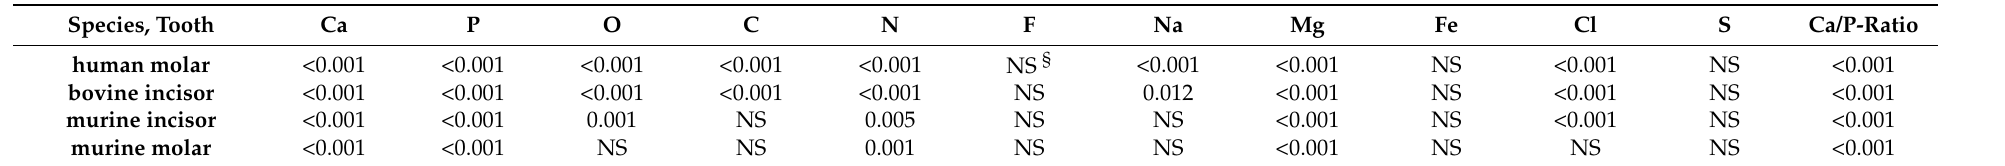
Table 2. p -values from pairwise tests between enamel and dentin for the summarized areas in every group of teeth for all elements and the Ca/P-Ratio (results depicted in Figure